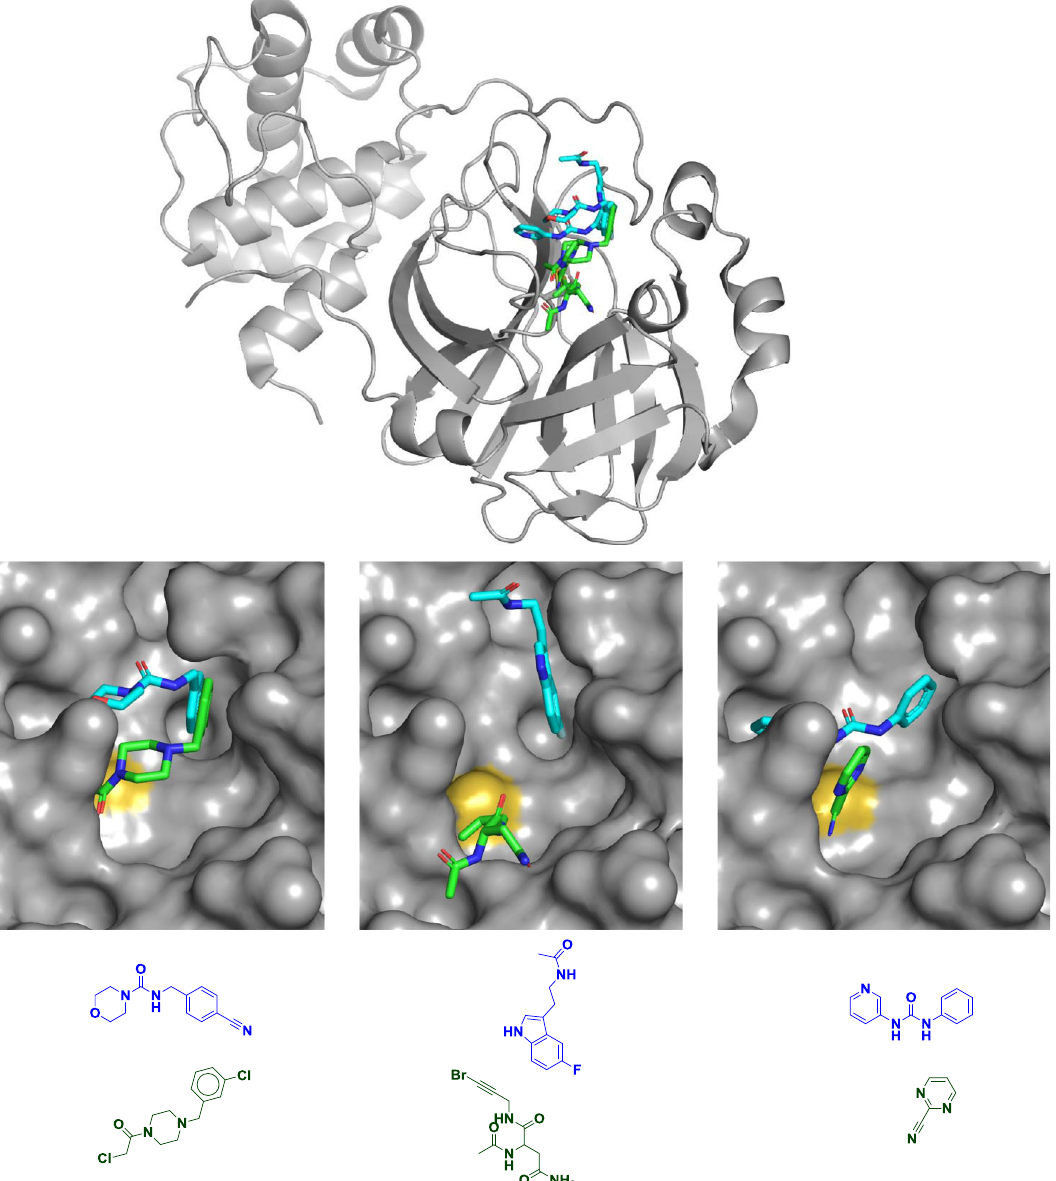
Fig. 1 Diverse fragments in diverse binding sites. M pro structure and chemical structures of six fragments bound to the active site of M pro to illustrate their multiple binding locations. Although the catalytically active enzyme is an obligate homodimer, only one monomer is shown (top) for clarity. Covalent fragments are shown in green, noncovalent fragments are shown in blue or cyan, and the catalytic cysteine sulfur atom is shown in yellow. All six fragments are shown overlaid in the top panel, in pairs in the middle panel, and as chemical structures in the bottom panel; overlays are shown to illustrate the range of binding modes though each fragment was crystallized individually. All three noncovalent fragments shown come from a “ poised ” fragment library designed for rapid follow-up chemistry through the urea or amide linkages 13 . Most of the covalent fragment hits disclosed are chloroacetamides (bottom left), but others include bromoalkynes (bottom middle) and aromatic nitriles (bottom right). PDB codes are (from left to right and top to bottom): 5RFE, 5R7Z, 5R83, 5RET, 5RG3, and 5RHB. As noted by Douangamath et al. 1 , overlaying structures suggests many opportunities for fragment merging, for example the two compounds on the